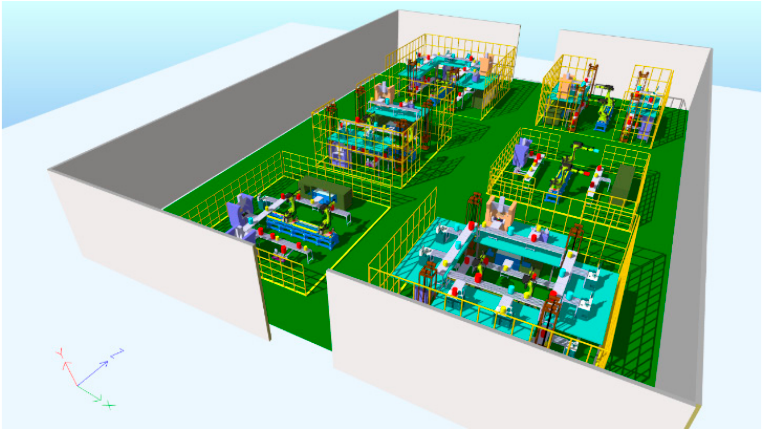
Figure 2. Stereoscopic diagram of MCIL.